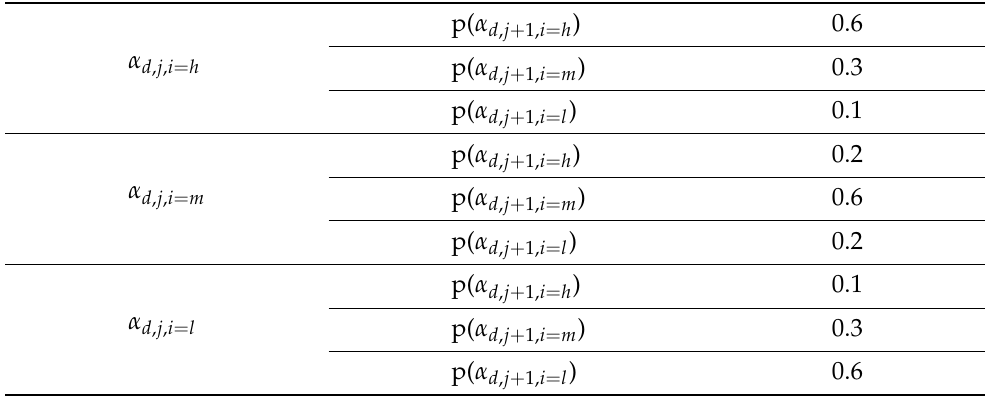
Figure 9. The steam demand profiles (D low , D nominal and D high ) of a production plant of INEOS in Köln (scaled). The lines between the demand profiles indicate the boundaries of the demand regions. Table 2. Dependent realisation probabilities defined for the case